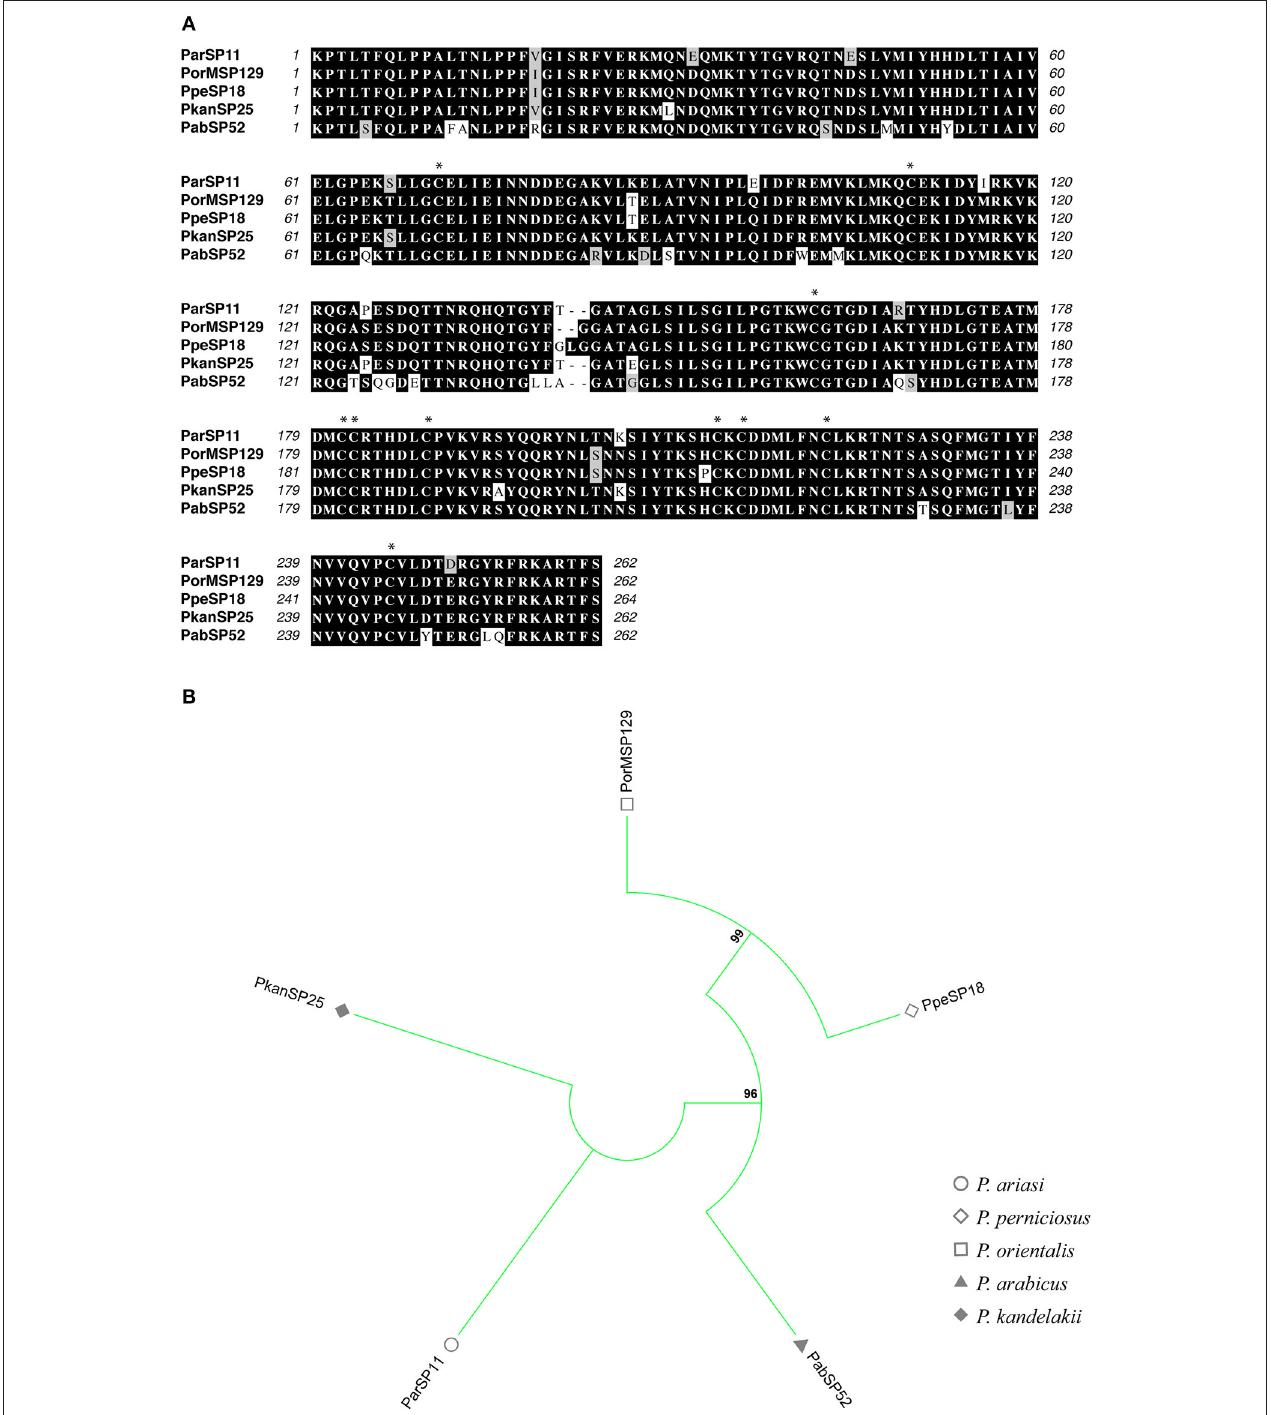
FIGURE 9 | Multiple sequence alignment and molecular phylogenetic analysis of the sand fly Phospholipase A2 salivary protein family. (A) Multiple sequence alignment of Phospholipase A2 proteins . ParSP11 ( P. ariasi ), PorMSP129 ( P. orientalis ), PpeSP18 ( P. perniciosus ), PkanSP25 ( P. kandelakki ), and PabSP52 ( P. arabicus ). Black background shading represents identical amino acids. Gray background shading represents similar amino acids. Asterisks indicate the conserved cysteine residues. (B) The evolutionary history of Phospholipase A2 salivary protein family was inferred by using the Maximum Likelihood method based on the JTT matrix-based model (Jones et al., 1992). Sand fly species are indicated by the different symbols in the legend on the right.